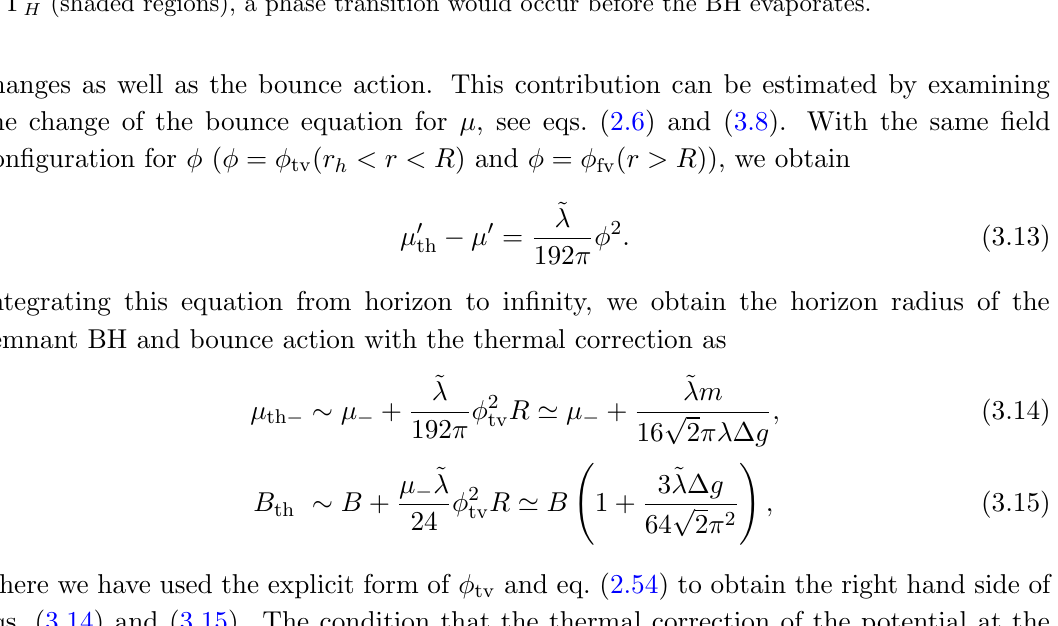
3 , Figure 6 . The vacuum decay rate as a function of M + in the case with (cid:21) = 4 (cid:25) , m = 2 (cid:2) 10 (cid:0) and g = 3 (or (cid:1) g = 0 : 88) for the toy potential V ( (cid:30) ) (eq. (2.48)) is shown. The blue dotted line is the decay rate without the thermal correction. The decay rates including thermal corrections with ~ (cid:21) = 4 (cid:25) (red solid), 10 3 (orange dotted), 10 4 (orange dashed), and 10 5 (orange solid) are plotted. The orange lines represent the case where there are many particles interacting with the scalar (cid:12)eld. For comparison, the evaporation rates with g H = 60 (brown dashed) and g H = 10 5 (black dashed) are also shown. The former one corresponds to the case of the SM. If a line of (cid:0) D comes below that of (cid:0) H (shaded regions), a phase transition would occur before the BH